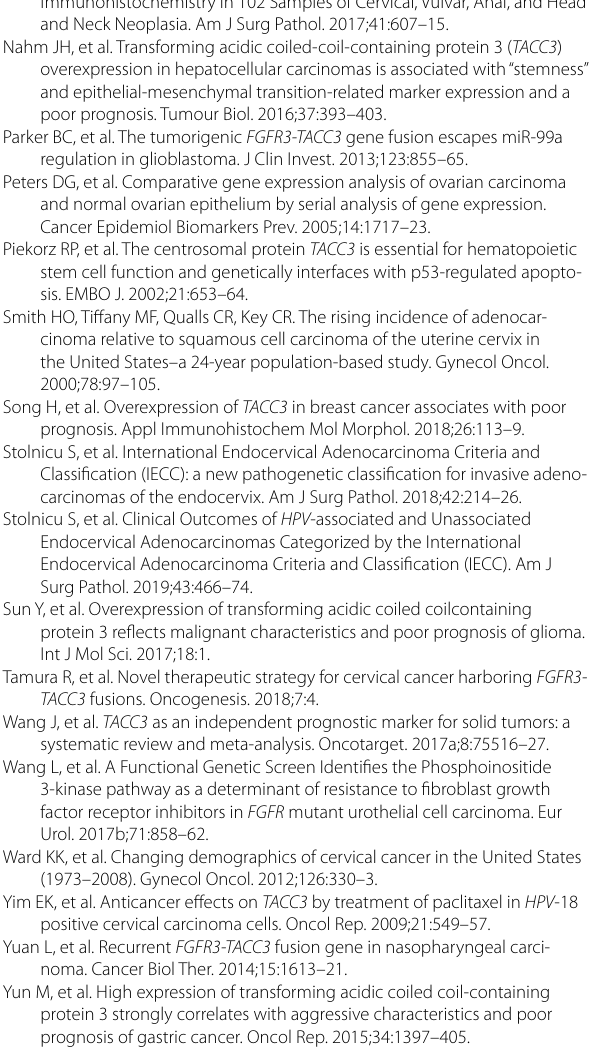
FIGO stage I endometrial cancer. J Magn Reson Imaging. 2016;43:316–24. Camp RL, Dolled‑Filhart M, Rimm DL. X‑tile: a new bio‑informatics tool for biomarker assessment and outcome‑based cut‑point optimization. Clin Cancer Res. 2004;10:7252–9. Capelletti M, et al. Identification of recurrent FGFR3-TACC3 fusion oncogenes from lung adenocarcinoma. Clin Cancer Res. 2014;20:6551–8. Carneiro BA, et al. FGFR3-TACC3 : A novel gene fusion in cervical cancer. Gynecol Oncol Rep. 2015;13:53–6. Du Y, et al. TACC3 promotes colorectal cancer tumourigenesis and correlates with poor prognosis. Oncotarget. 2016;7:41885–97. Duncan CG, et al. Integrated genomic analyses identify ERRFI1 and TACC3 as glioblastoma‑targeted genes. Oncotarget.